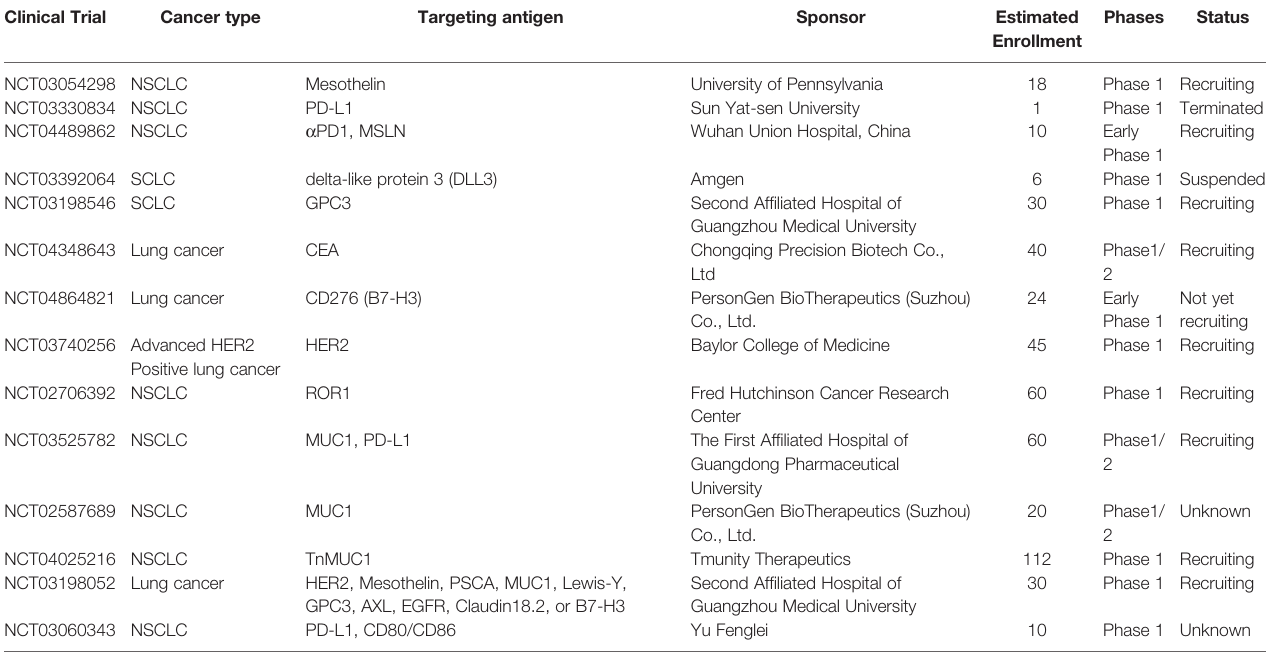
TABLE 2 | Underlying targeting antigens of NSCLC and SCLC for CAR-T cell therapy in clinical trials. Clinical